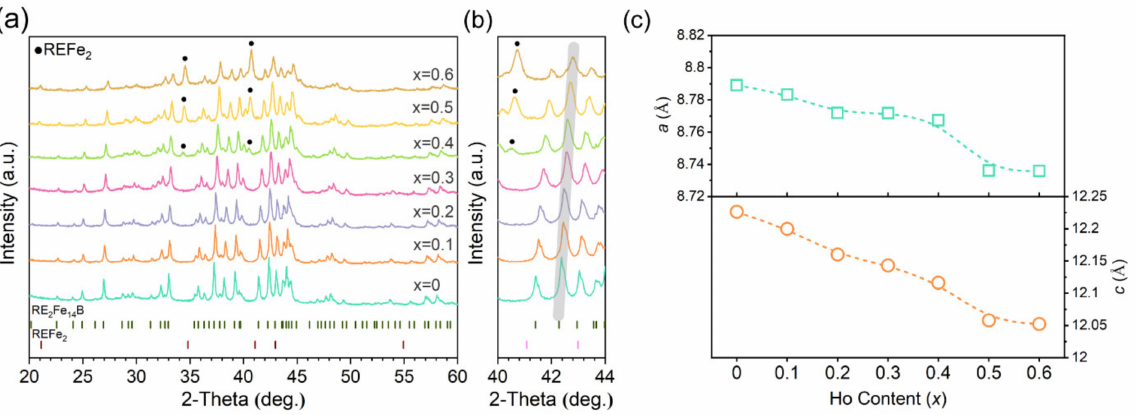
Figure 1. Phase structures of the NPHFBM alloys. ( a ) XRD patterns. ( b ) The enlarged XRD patterns within the 2 θ range of 40–44 ◦ . ( c ) The refined lattice parameters of 2:14:1